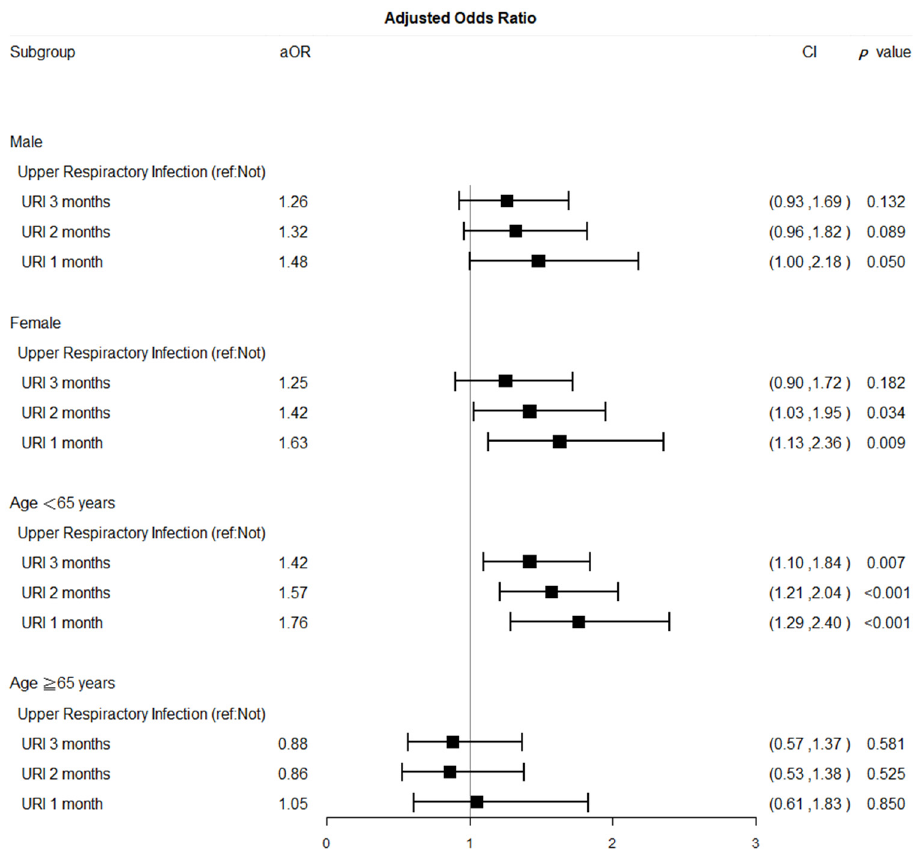
Figure 3. Forest plots of adjusted odds ratios for SSNHL comparing the different exposure time windows for acute URI and control groups by sex and age. (Adjusted covariates of ototoxic drugs, cholesterol-lowing drugs, and anti-platelet drugs listed in Table 1; Abbreviations: SSNHL, sudden sensorineural hearing loss; URI, upper respiratory tract infection; aOR, adjusted odds ratio; CI, confidence interval; ref., reference group; y, years old).